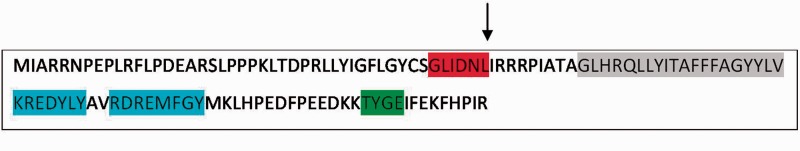
Graphic summary of NDUFC2 domain predictions. Red background, N-myristylation site and protein–protein interaction motif (http://www.predictprotein.org/); gray background, transmembrane domain; turquoise background, tyrosine kinase phosphorylation; green background, casein kinase II phosphorylation site. Arrow points to amino acid position 46.